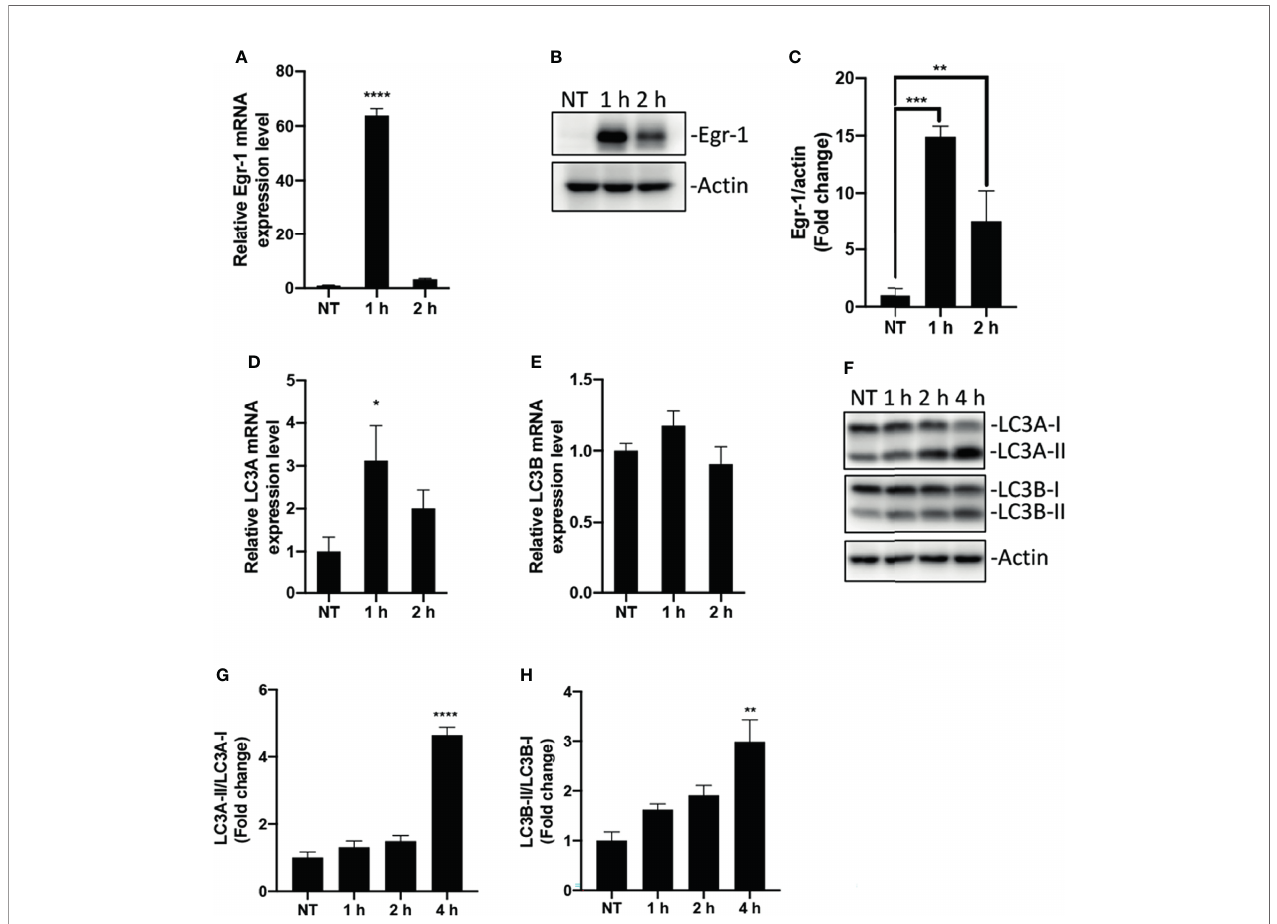
FIGURE 1 | Egr-1 expression and autophagy were induced by P. aeruginosa in macrophages. RAW264.7 macrophages were infected with P. aeruginosa PAO1 at an MOI of 10 for 1 h, 2 h, 4 h or left untreated (NT). The total RNA isolated from these cells was reverse transcribed to cDNA and subjected to real-time quantitative PCR for assessing the gene expression of Egr-1, LC3A and LC3B. The mRNA levels of Egr-1, LC3A and LC3B were normalized to endogenous control b -actin (A, D, E) (n = 3 ± SEM; *p < 0.05; ****p < 0.0001). Cell lysates were subjected to Western blotting for analyzing the protein expression levels of Egr-1, LC3A and LC3B, and actin was used as a loading control. Blots are representative of three independent experiments (B, F) . Densitometry analysis of Egr-1 protein levels and the ratio of LC3-II to LC3-I was normalized to actin, and data were presented as fold change (C, G, H) (n = 3 ± SEM; *p < 0.05, **p < 0.01, ***p < 0.001, ****p <